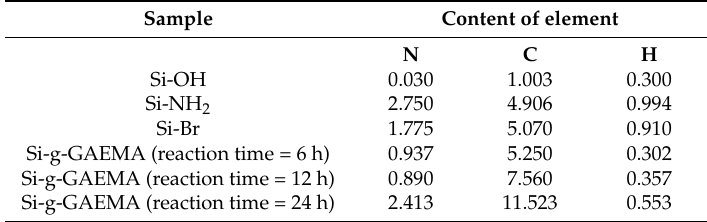
Table 1. Elemental analysis of the Si-OH, Si-NH 2 , Si-Br, and Si-g-GAEMA. Table 1 . Elemental analysis of the Si-OH, Si-NH 2 , Si-Br, and Si-g-GAEMA Sample